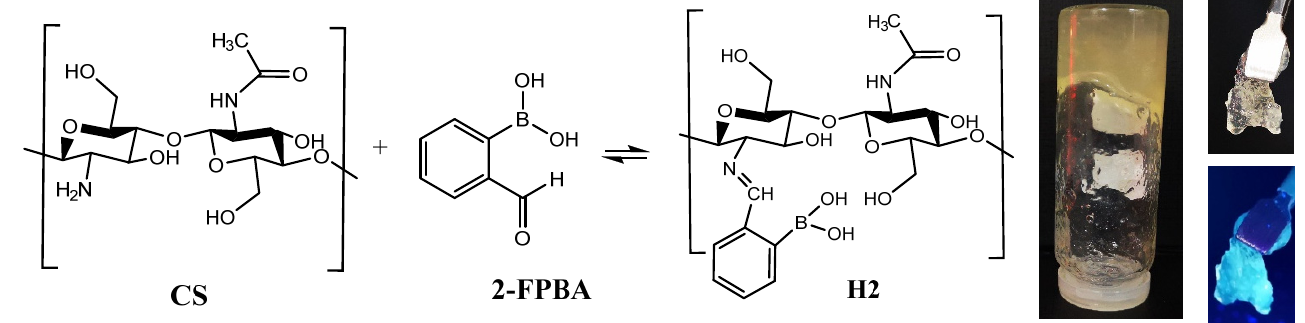
Figure 1. Imination reaction of chitosan with 2-formyl-phenyl-boronic acid and images of the obtained hydrogel, in normal light and when illuminated with a UV lamp.